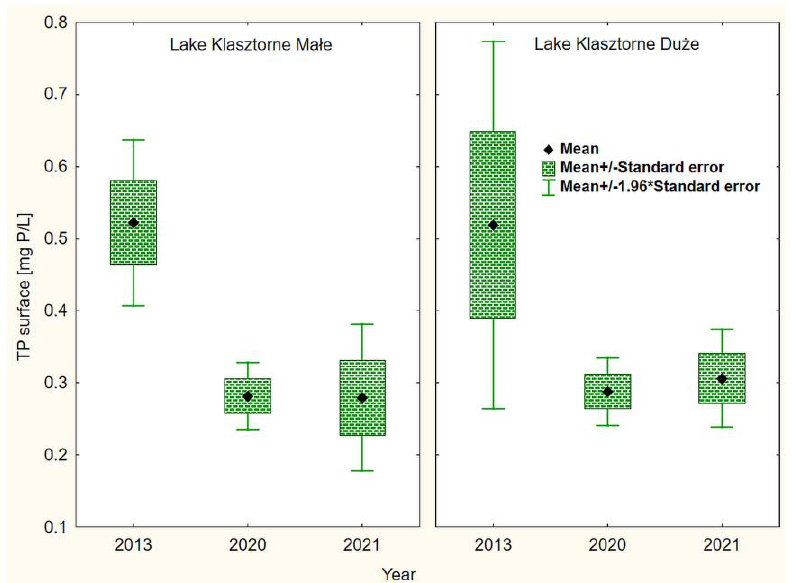
Figure 13. Average annual values of TP in the surface water of Klasztorne lakes in selected research years.